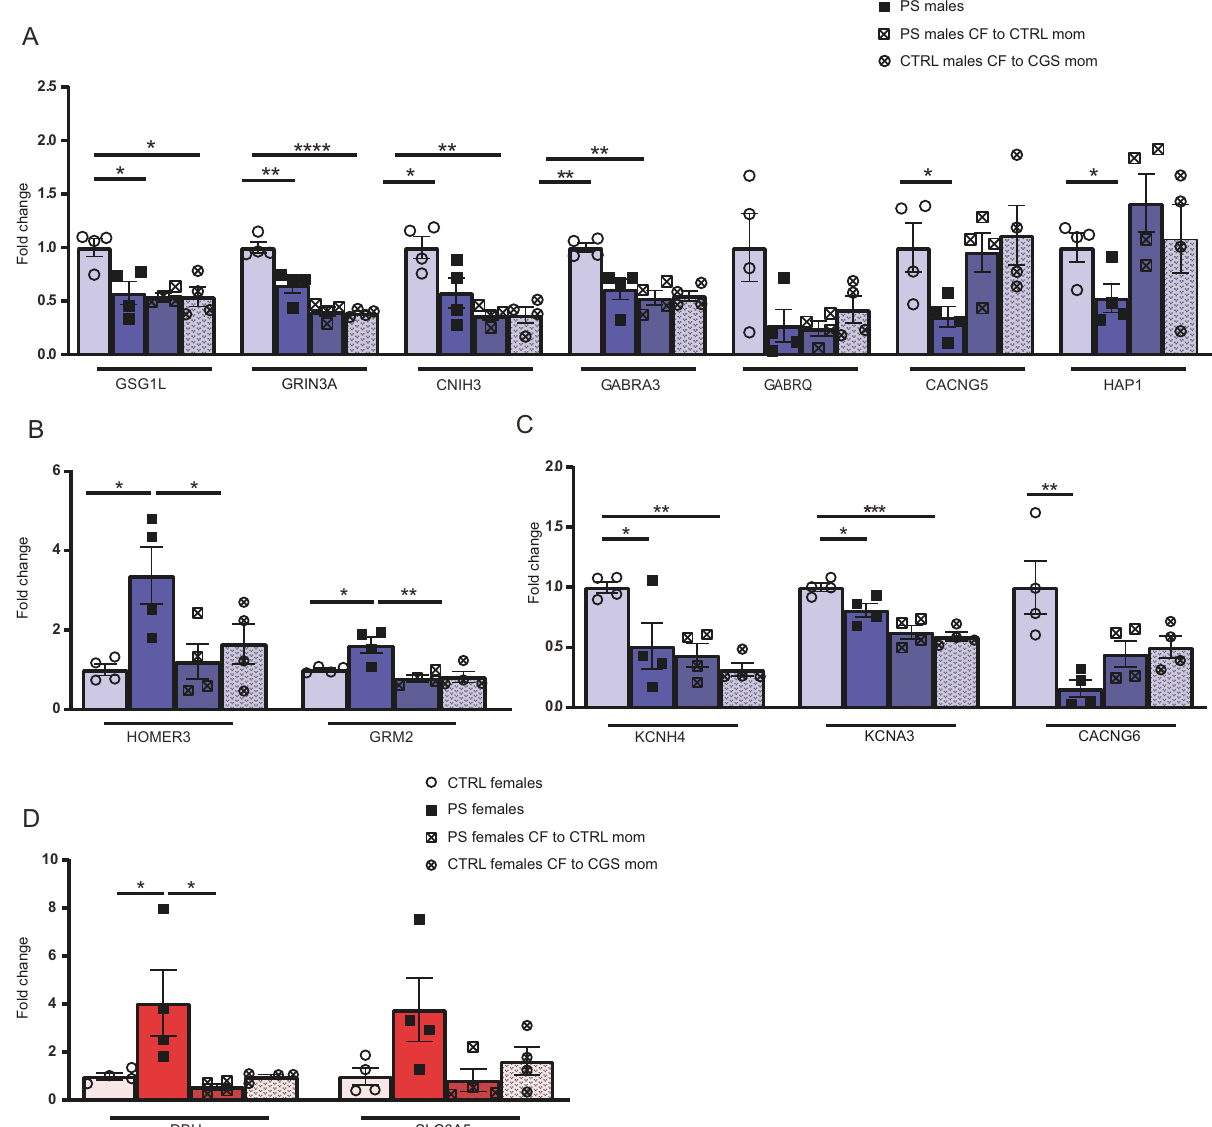
Fig. 4 Validation of RNA-seq results through qPCR and effects of CF on gene expression. A Validation of RNA-seq results for a subset of genes con fi rms downregulation in genes associated with glutamatergic and GABAergic neurotransmitter systems in PS males that are not reversed by changes in postnatal maternal environment. B Reversal of genes associated with metabotropic glutamate neurotransmission are observed in PS males following CF. C qPCR data also con fi rms downregulation of genes encoding ion transporter complexes in PS males which are not reversed by alterations in maternal environment. D Validation of RNA-seq results in PS females con fi rms upregulation in DBH and a trend towards increased levels in SLC6A5 transporter. CF induces normalization of alterations in DBH in PS females, associated with NE neurotransmission. N = 4 per group. Data presented as mean ± SEM. * p < .05, ** p < 0.01, ***< p < .001, **** p < 0.0001, unpaired two-tailed t -test for differences between Ctrl and PS offspring, t wo-way ANOVA followed by Tukey ’ s post hoc test for CF gene expression analysis with PS × CF